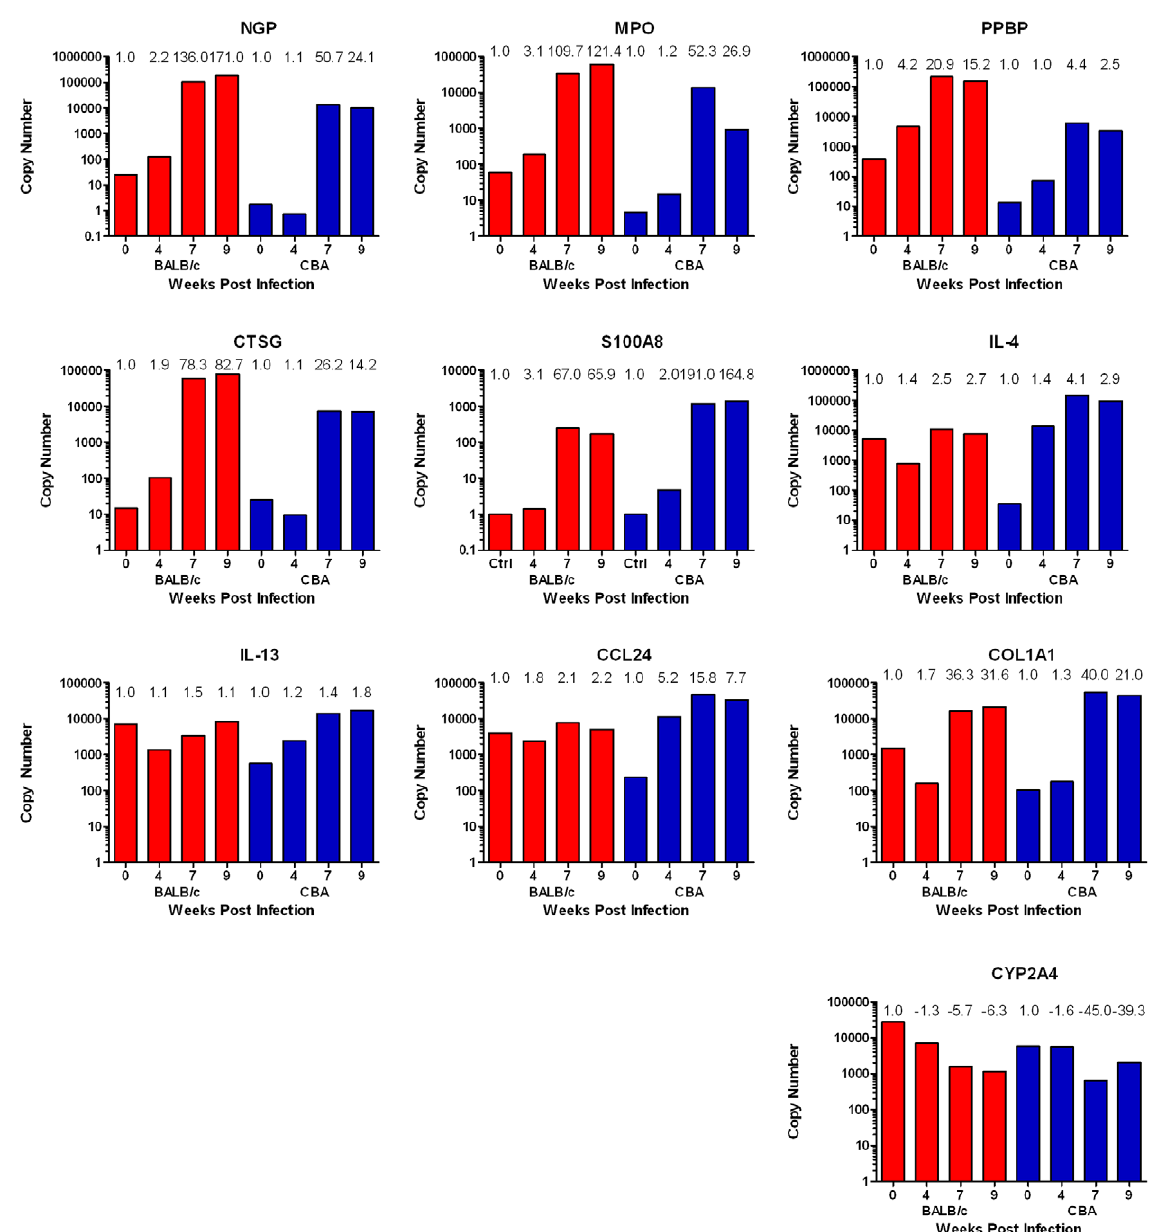
Figure 6. Real-time PCR validates microarray results. Microarray fold-changes relative to uninfected controls for each strain and time-point are presented above the individual bars. Real-time PCR data are presented in the column graphs as copy number. PCR copy number provides an absolute comparison between all groups; microarray fold-change provides a relative comparison between all groups, as these data are normalised to respective control